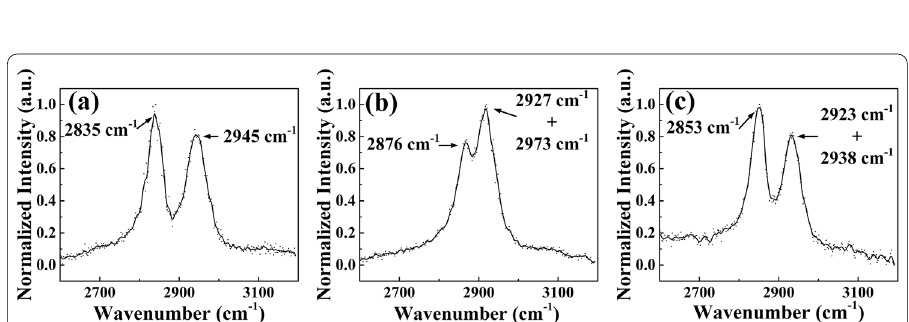
Fig.9 CARS spectra of a methanol, b ethanol, and c cyclohexane detected by CARS fiber